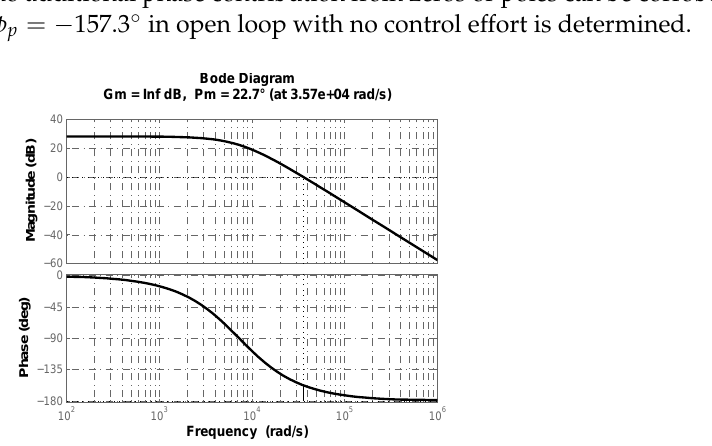
Figure 3. Frequency response of buck converter from Figure 1 and parameter values of Table